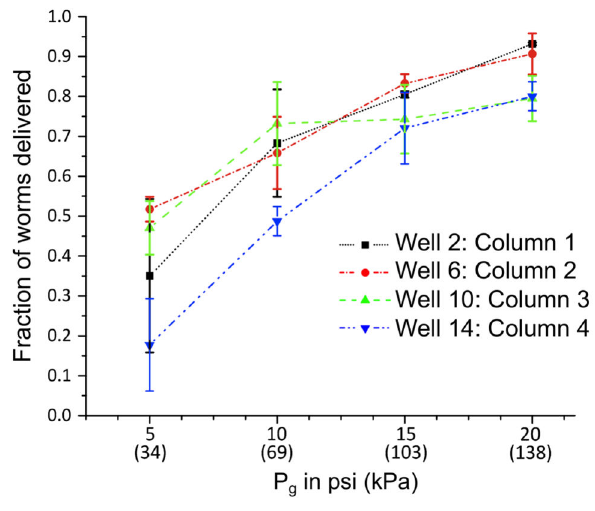
Figure 3. Worm population delivery as a function of applied pressure. The fraction of worm populations loaded in 4 representative on-chip wells from 4 different columns of the Population Delivery Chip that are delivered to the outlet of the device as a function of pressure applied at the gasket and the Main Channel Flush . doi: